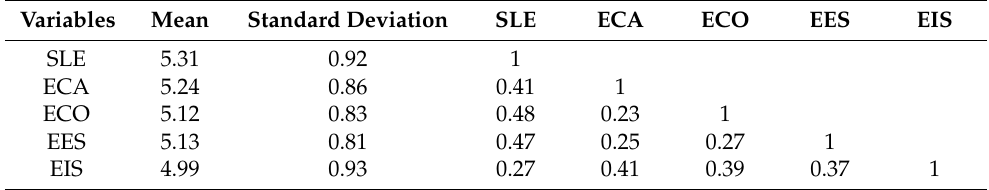
Table 1. Descriptive and correlations